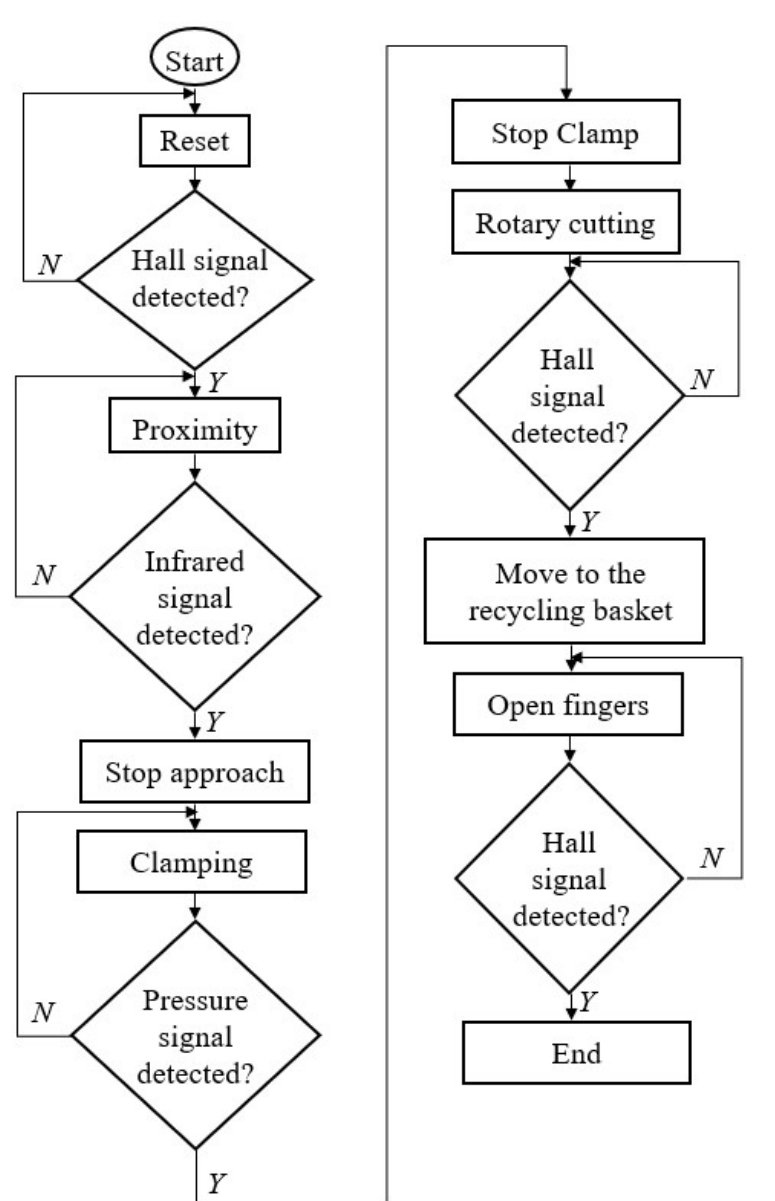
Figure 6. Flow chart of harvesting operation for end-effector.